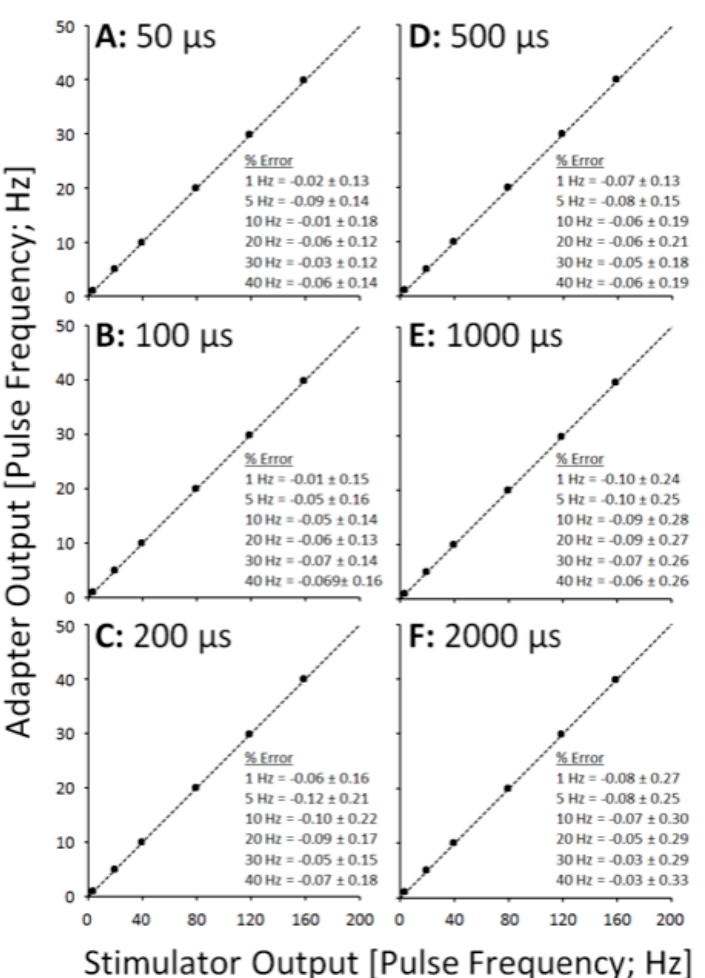
Figure 5. Scatter plots showing adapter pulse frequency outputs vs. stimulator pulse frequency out- puts across pulse durations ( A – F ).